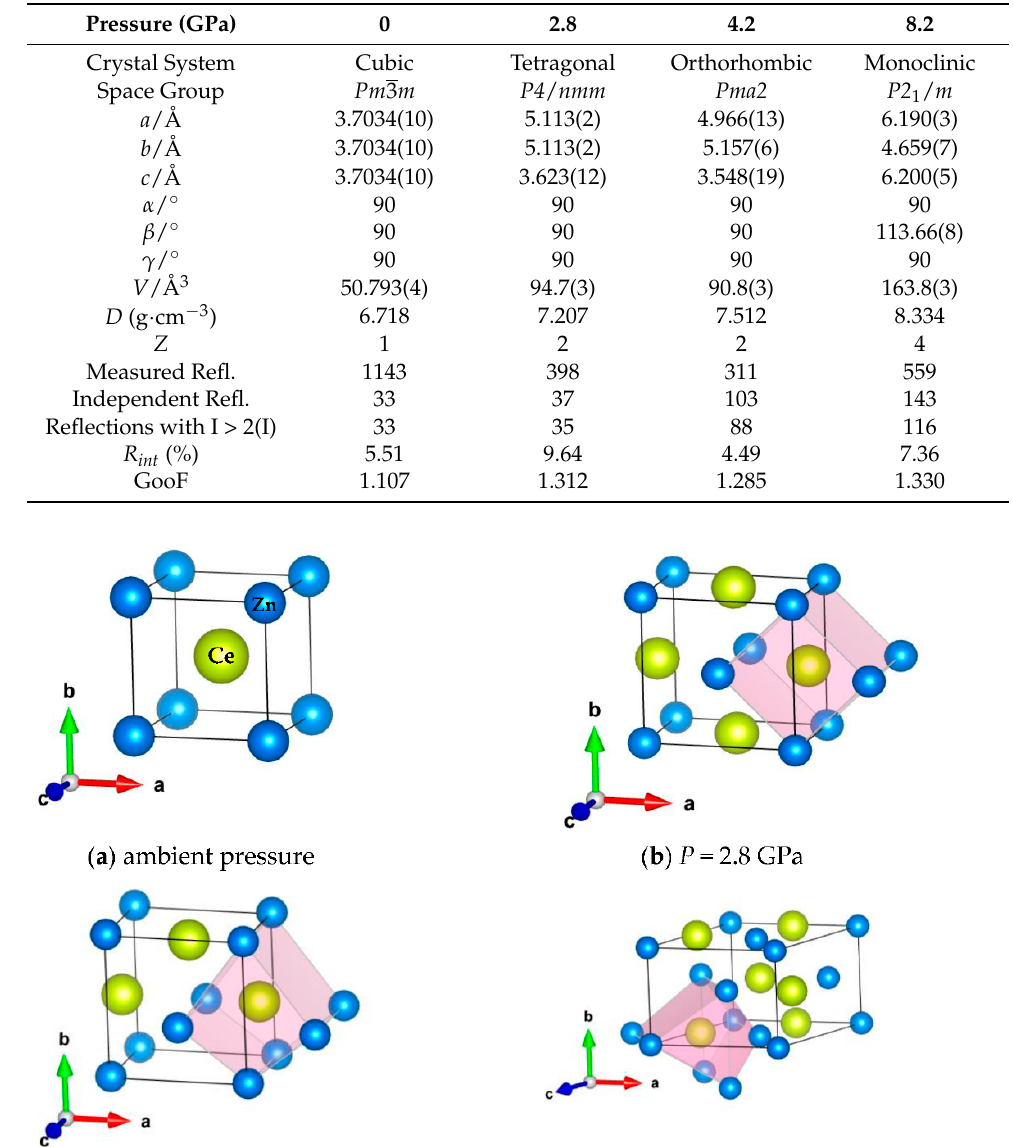
Table 1. Crystallographic parameters of CeZn single crystal at some selected pressures.